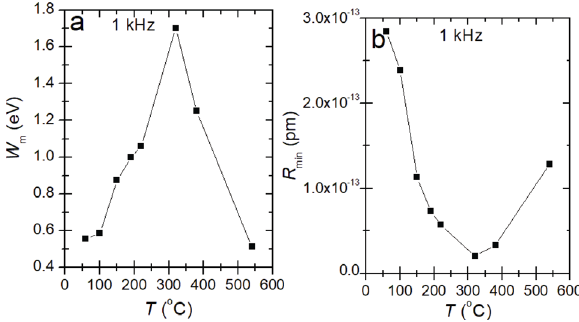
Fig. 10 Temperature dependence of the Fermi-level density of states ( N ( E f )) of NBT ceramics at several frequencies. Insets (a) and (b) show the frequency dependence of N ( E f ) at different temperatures, which demonstrates the different characteristics of this dependence for the temperature ranges from RT to about T d and above T d .